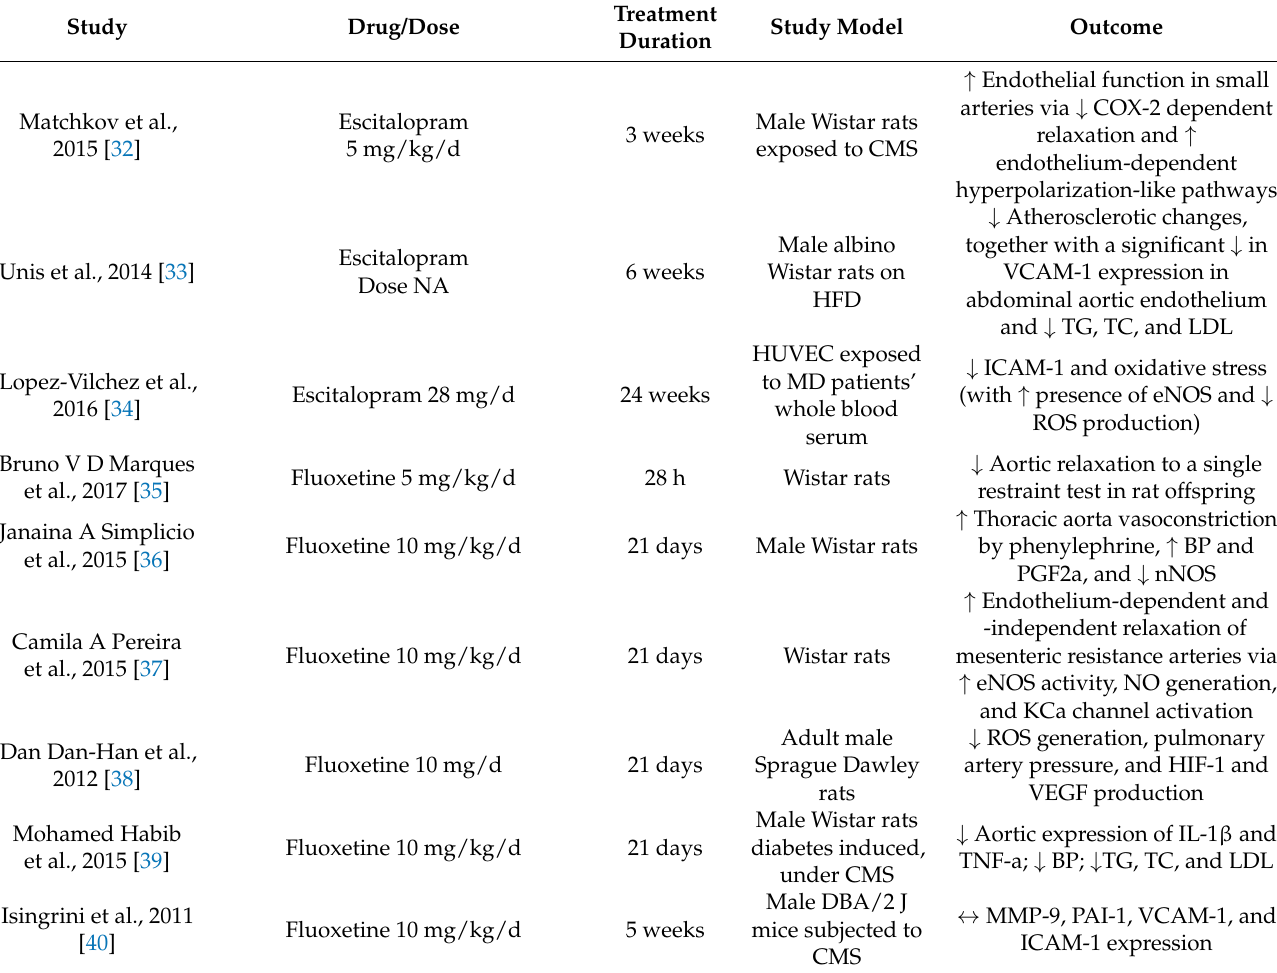
Table 1. Experimental studies on antidepressants and vascular